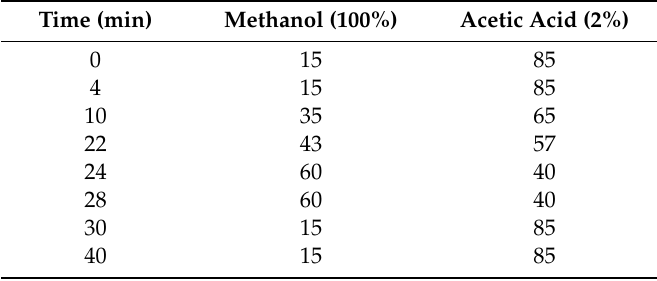
Table 1. Time-course changes in the composition of the mobile phase during linear gradient analytical